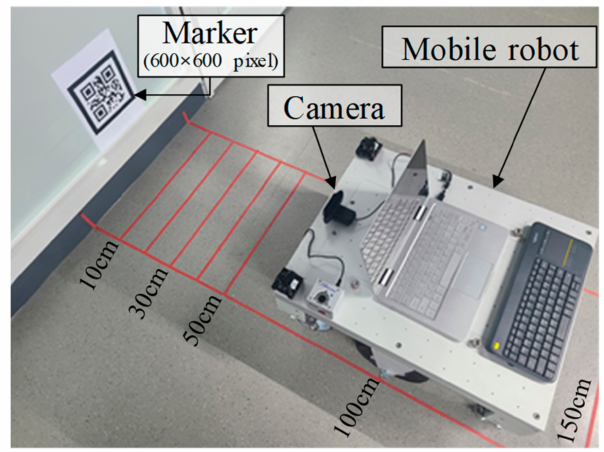
Figure 12. Test setup for verification of proposed